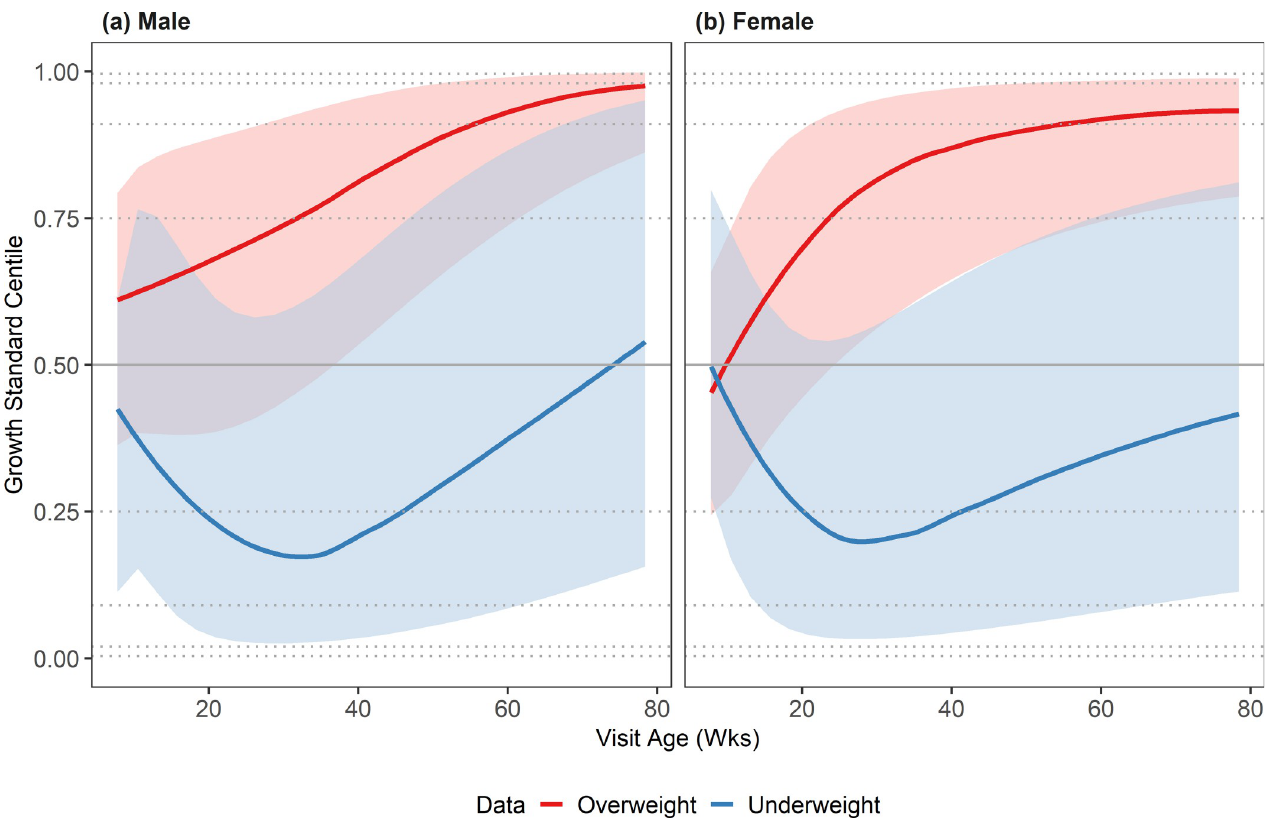
Fig 3. Median and interquartile weight by age (on the centile scale) for DSH kittens in the underweight subset (blue) and overweight subset (red). Plots are split by sex: (a) male and (b) female. On each graph, the median is depicted by the solid blue/red line, the interquartile range by the shaded region, and the standard centiles (0.4%, 2%, 9%, 25%, 50%, 75%, 91%, 98% and 99.6%), as calculated from the growth standard population, are shown by the grey horizontal lines (dotted, apart from 50%, which is shown as solid). Some centile crossing is observed in both groups up to 20-30wks but the overweight kittens continue to cross centiles throughout the growth